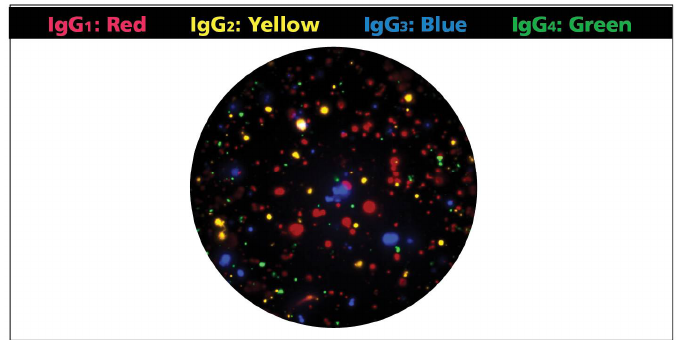
Figure 2. Representative four-color well. The membrane was coated with anti-κ/λ capture antibody and polyclonally activated peripheral blood mononuclear cells (PBMC) were plated at 50,000 cells/well. Detection regents for each of the four IgG subclasses were added to visualize the membrane-bound IgG molecules. Images were captured for each individual fluorescent channel (see Figure 1) and superimposed using the following artificially assigned colors for each color plane: IgG1: Red; IgG2: Yellow; IgG3: Blue; and IgG4: Green.